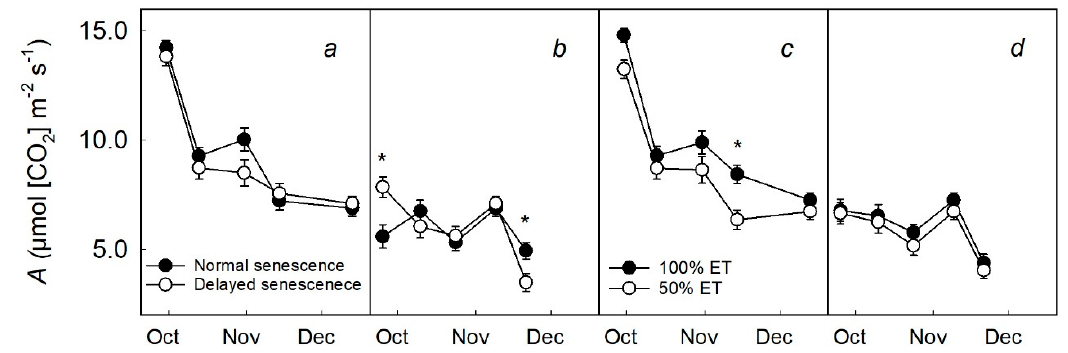
Figure 1. Average leaf CO 2 assimilation ( A ) of young peach trees ( n = 24) according to: (i) Senescence: trees in 2016 ( a ) and 2017 ( b ) grown under ambient fall temperatures (normal senescence, filled circles) or grown under the greenhouse environment, which resulted in a delay of senescence (delayed senescence, unfilled circles) and (ii) soil moisture: Trees in 2016 ( c ) and 2017 ( d ) that were well-watered (100% ET, filled circles) or water-deficient trees (50% ET, unfilled circles). Error bars represent ±standard error of the mean while asterisks show statistical differences ( p ≤ 0.05) between the two treatments.